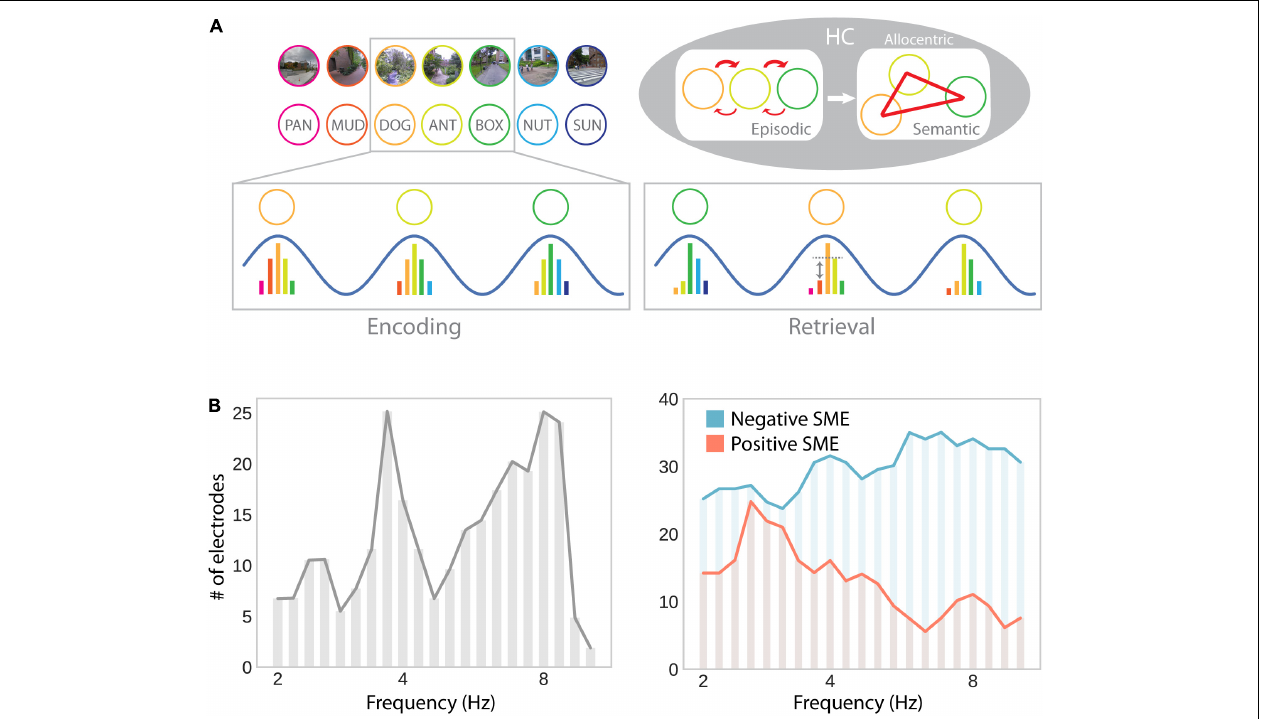
FIGURE 6 | Theta oscillations in episodic memory formation and retrieval. (A) Model suggesting a common role for hippocampal theta oscillations and phase precession in memory for spatial and non-spatial sequences (e.g., during navigation or a list-learning task; Buzsáki, 2005). Successive firing of hippocampal cells within a theta cycle establishes temporal associations between both place and item representations through synaptic plasticity, which favors associations in the forward direction. Multiple encounters of the same items/places in different serial order establishes semantic/allocentric representations of conceptual and physical space. In part adapted with permission (Buzsáki, 2005) from Wiley Periodicals. (B) Hippocampal electrodes showing theta oscillations around 3–4 and 8–9 Hz, analogously to theta effects during navigation (see Figure 3B ; left ), as well as positive and negative subsequent memory effects (SME; right ). Positive SMEs predominate around 3–4 Hz. Adapted with permission (Lega et al., 2012) from Wiley